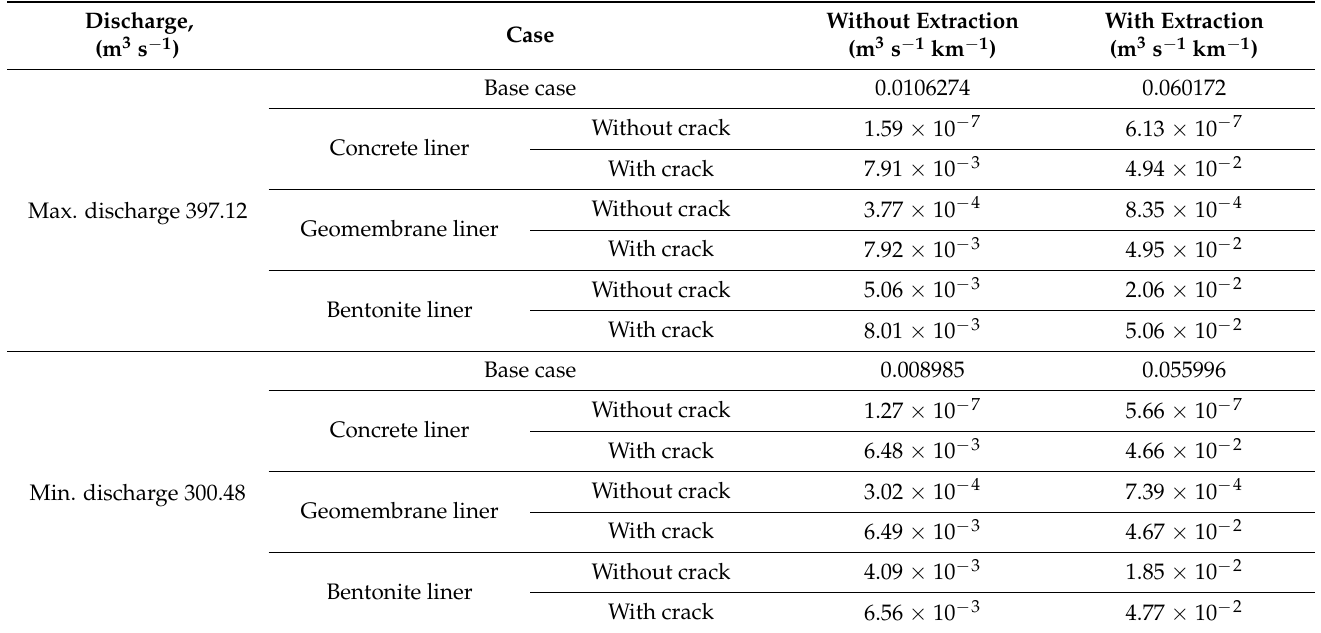
Table 3. Results of canal seepage with a lining and cracks, considering